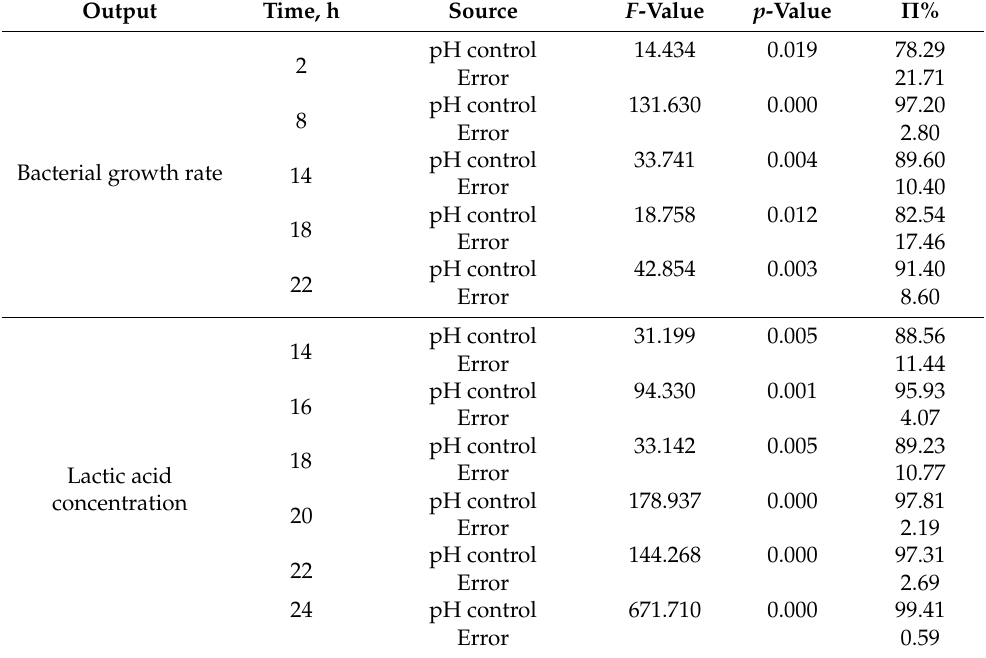
Table 1. One-way ANOVA